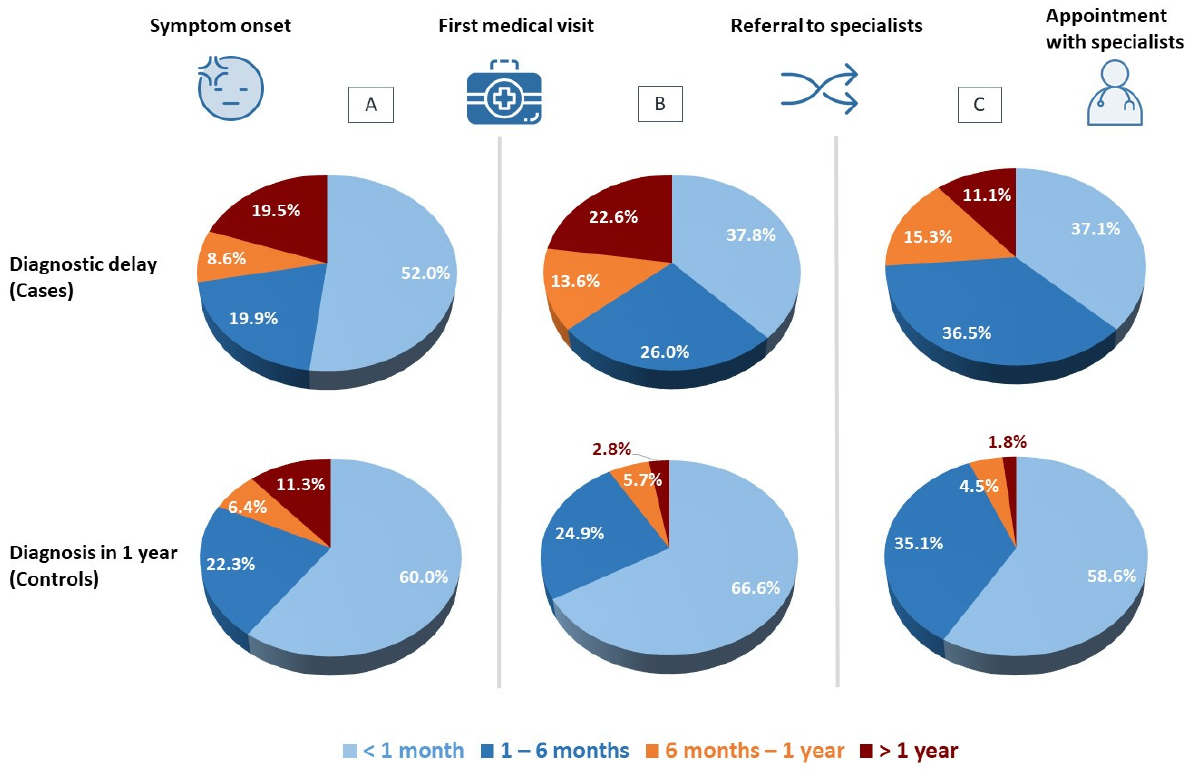
Figure 1. Time periods elapsed: ( A ) from symptom onset to first medical visit; ( B ) from first medical visit to referral to specialist; ( C ) from referral to appointment with specialist.